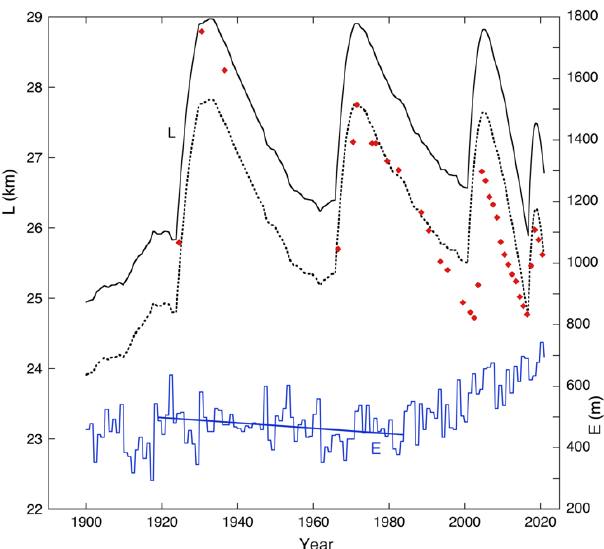
Figure 7. Simulation of glacier length L achieved after optimiza- tion of the model parameters. Observations are indicated by red dots. The blue line shows the optimal ELA forcing (scale at right). Glacier length simulated for a case without surging is shown by the dotted line.